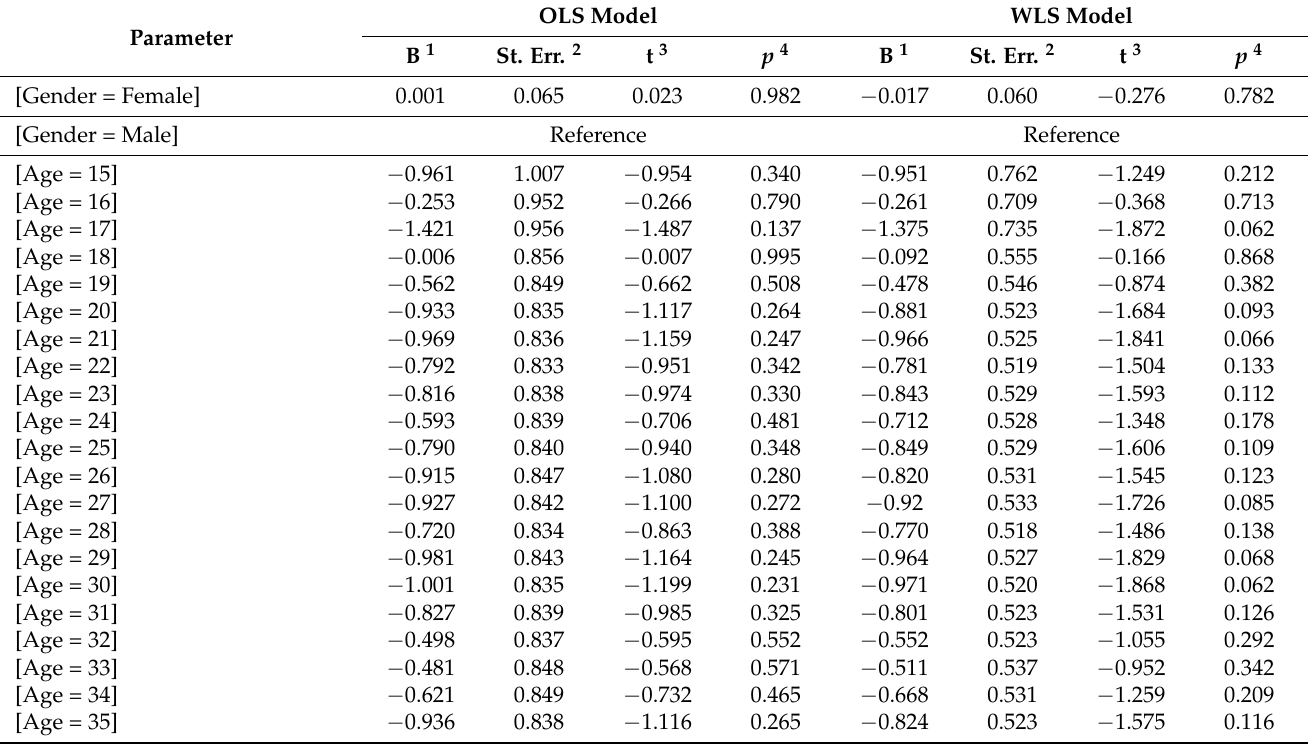
Table 4. Parameter estimates for the OLS and WLS models of car ownership in